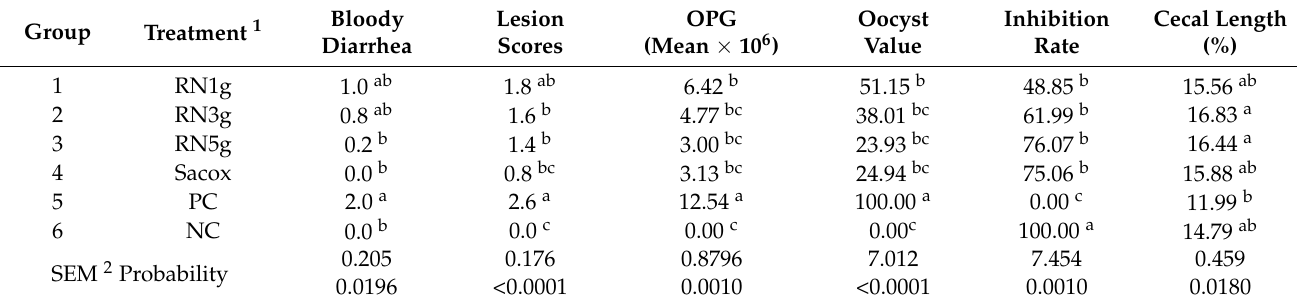
Table 5. Effect of different experimental supplements and challenge on oocyst/gram (OPG) output, lesion score, oocyst value, inhibition rate, and cecal length at 7 d postinoculation.